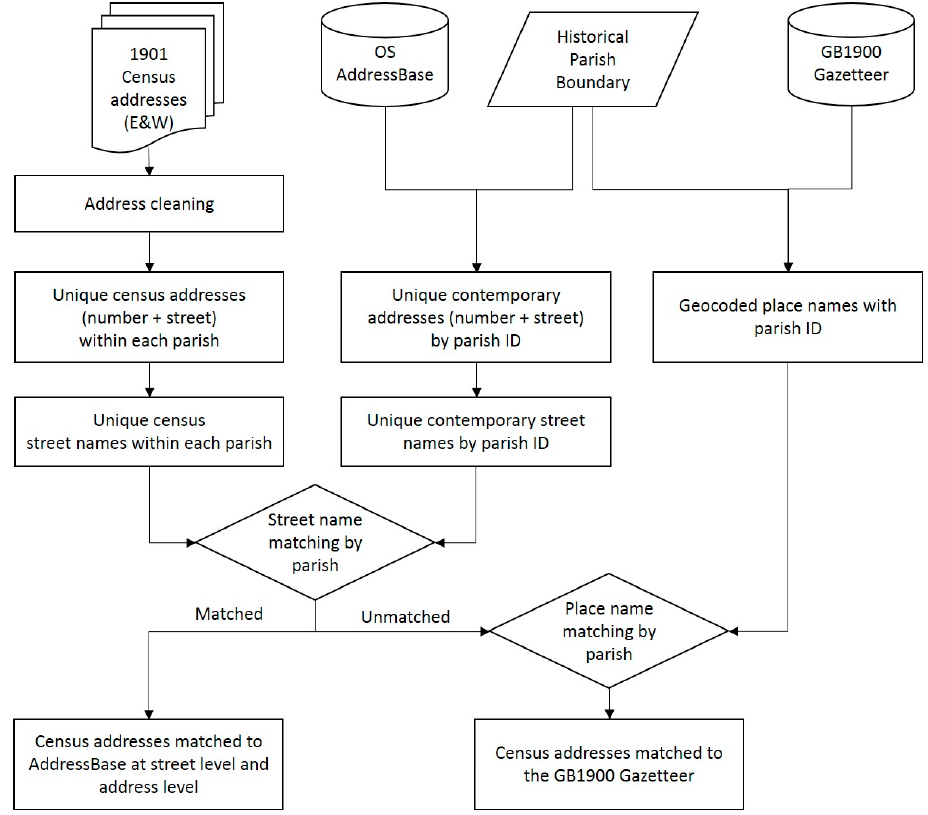
Figure 2. The workflow of the geo-referencing process.